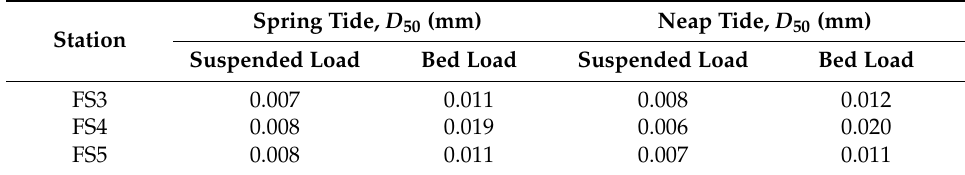
Table 1. D 50 of suspended and bedload during the wet season (2nd half of June 2015). Station